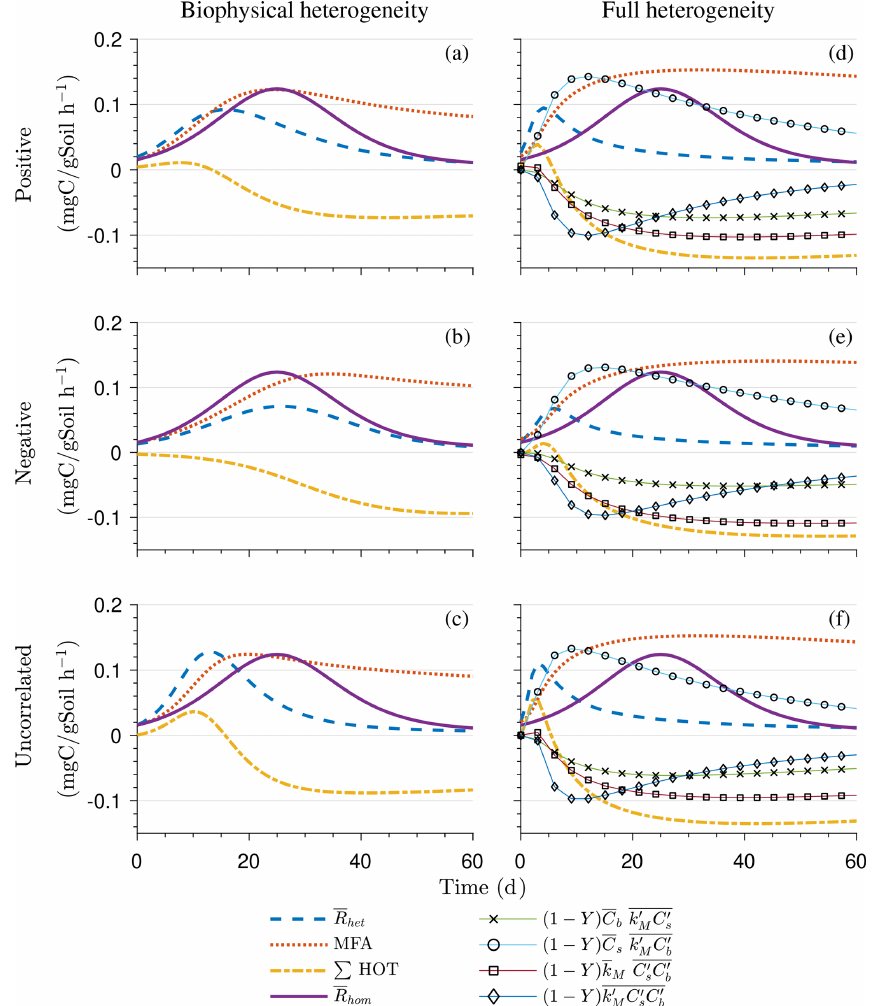
Figure A4. Scenario 2 (HS simulation with multiplicative kinetics): temporal evolution of mean respiration rate in the heterogeneous system ( R het ), which includes the mean field approximation (MFA) and second-order terms, and the respiration rate in the homogeneous system ( R hom ) for (a–c) the biophysically and (d–f) the fully heterogeneous system with positive (a–b) , negative (c–d) , and uncorrelated (e–f) substrate and microbial C for multiplicative